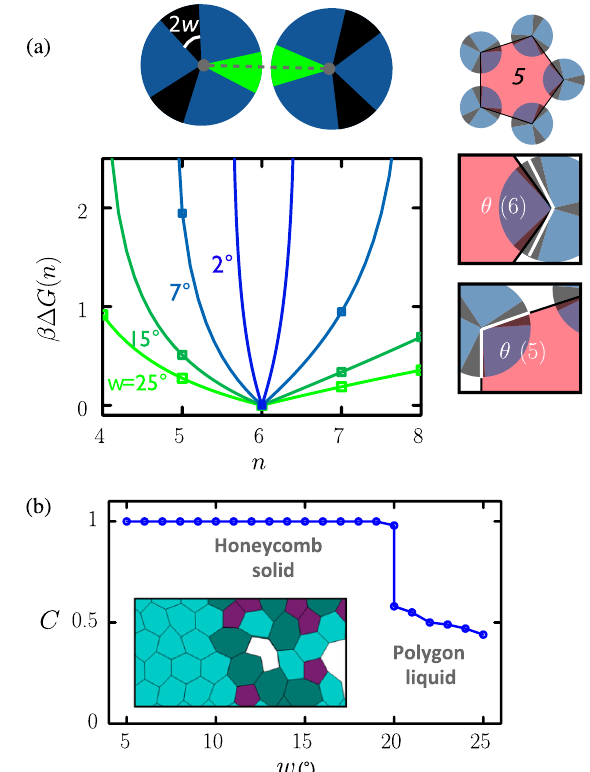
FIG. 3. Model capturing the microscopics of Fig. 2 captures the range of phase behavior seen in experiments. (a) The rotational free energy per disk within bound n -gons is narrow when interaction flexibility w is small and broad when w is large. Although different in origin and functional form to the thermo- dynamics governing TBPB polygon formation, shown in Fig. 2(b), its essential features — the hexagon is favored, and other polygons are allowed with some geometrical strain — are similar. Top: Model geometry. Right: Sketches demonstrating the geometric strain felt by disks in nonhexagonal polygons; θ ð n Þ ¼ ð n − 2 Þ π =n is the internal angle of a regular n -gon. (b) Thermo- dynamic simulations ( T= ϵ ¼ 0 . 16 ) show that the stable network undergoes a thermodynamic order-disorder transition as a func- tion of stripe width w . This thermodynamics interpolates between examples of network order (panel A) and order-disorder coex- istence (panel E) shown in Fig. 1. Network order C is the number of hexagons divided by the total number of all polygons. Inset: Snapshot (Fig. S3) at thermodynamic order-disorder coexistence with w ¼ 25 ° (Fig.